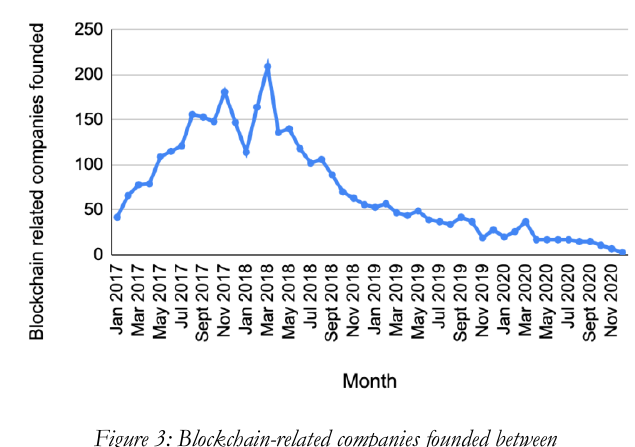
Figure 3: Blockchain-related companies founded